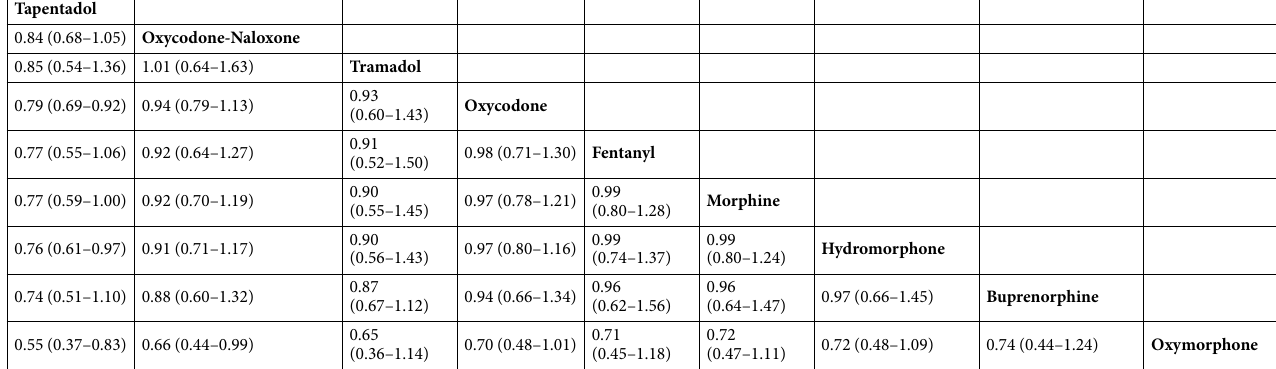
Table 2. League table showing the odds of the incidence of ADVERSE EVENTS with treatment of various opioids. OR < 1 means the treatment in top left is better.